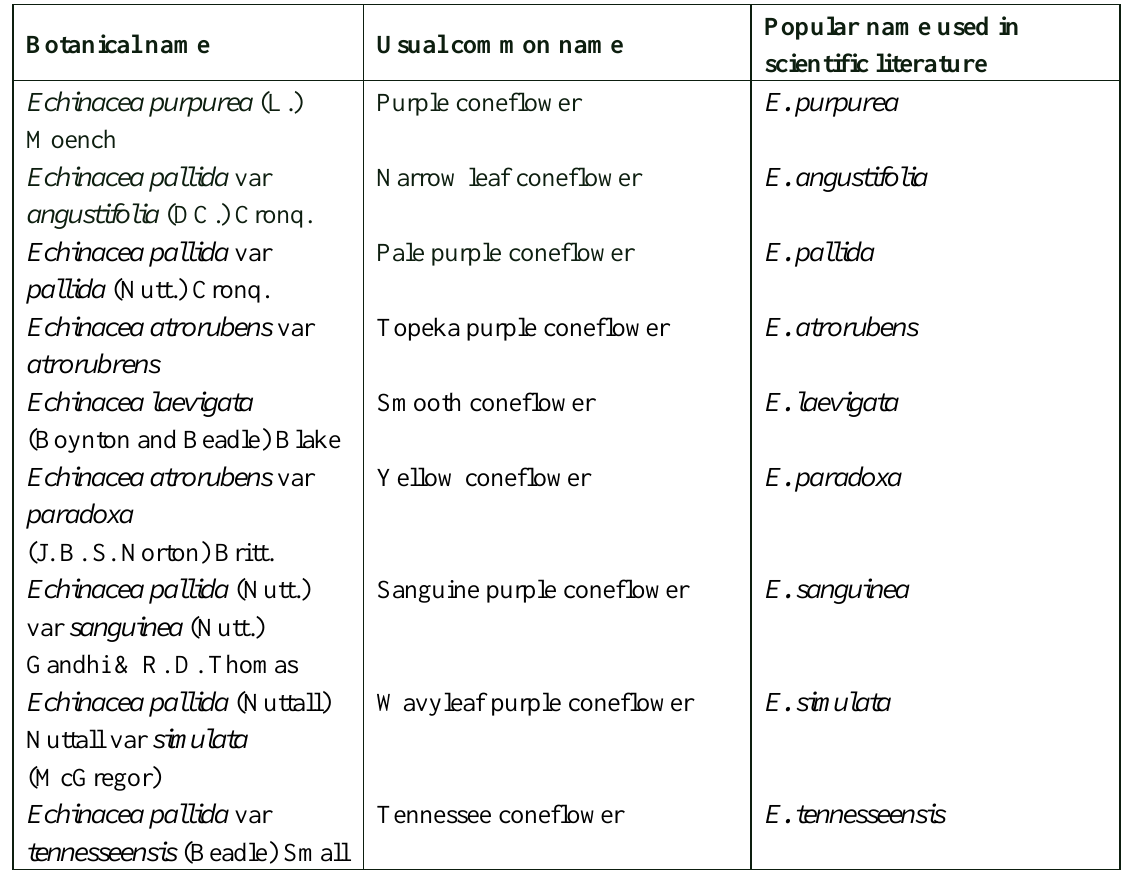
Table 2. Taxonomy of Echinacea